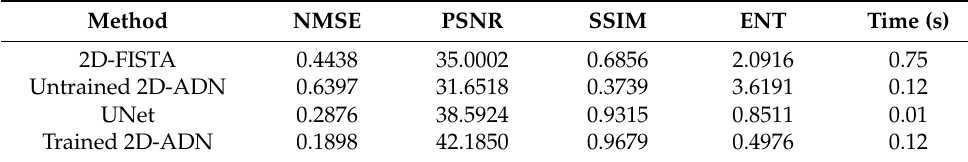
Table 7. Quantitative performance evaluation for the 2D incomplete simulation data.